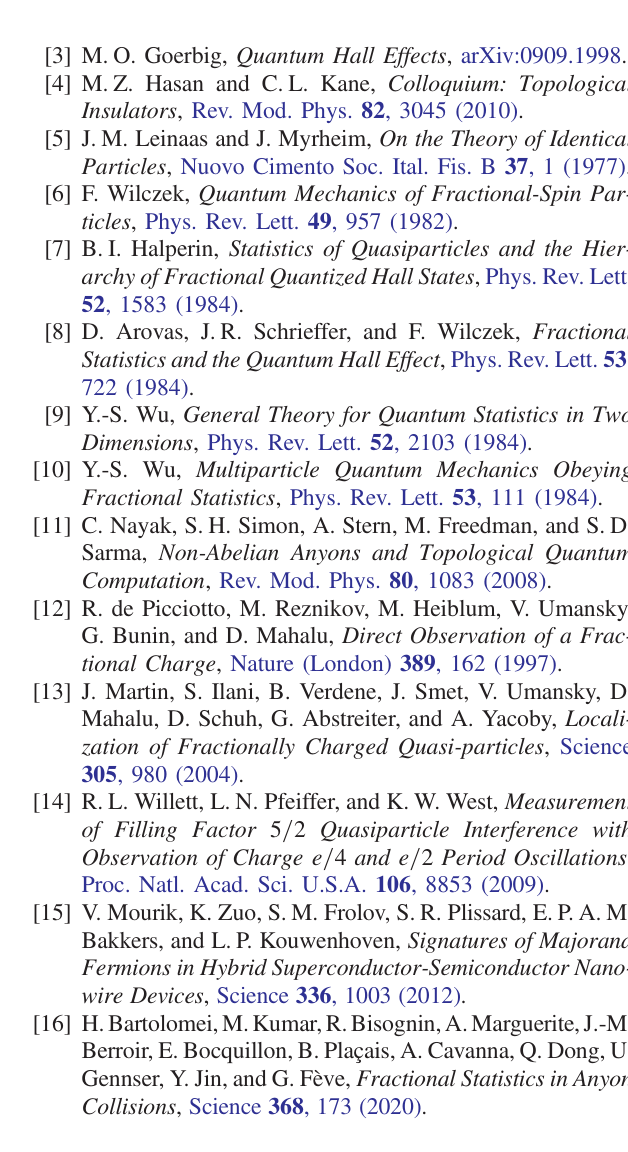
11. Differential scattering cross section d σ =d ϕ as a function of the scattering angle ϕ for indistinguishable molecules with statistical parameter α ¼ 0 . 5 and several values of the relative incident momentum ka in the hard-disk (a) and dipolar (b) interaction HD ; D cases. The curves plotted with the same color in these two panels satisfy the relation Eq. (70) and are thus expected to have the same angular oscillation period. Panel (c) shows the oscillation period δϕ (calculated as the difference between the angular position of the two − 1 for hard-disk impurities (red circles) and as a function of ð 2 ka − 1 = 3 for dipolar ones (blue central minima) as a function of ð ka HD Þ D Þ squares). The dashed black lines are the respective linear